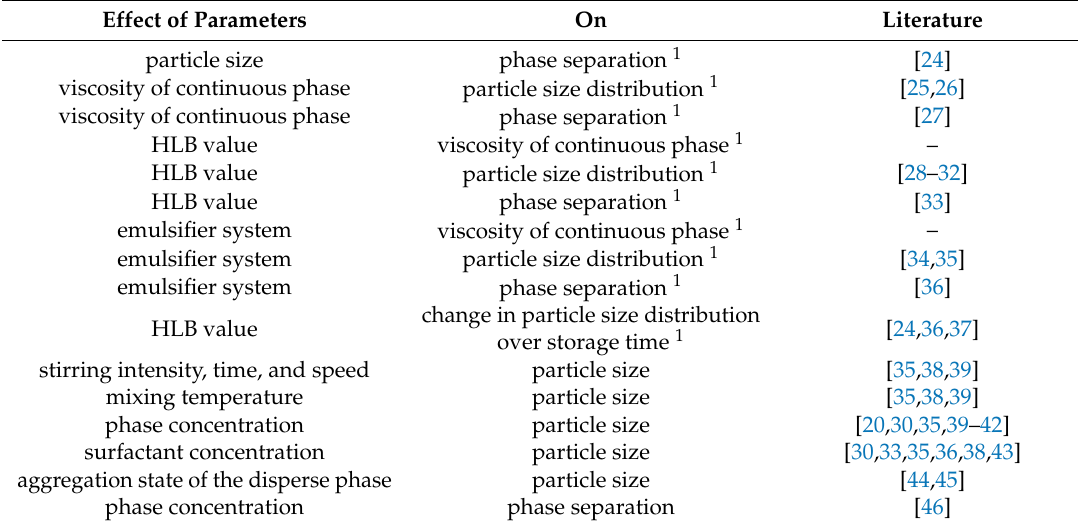
Table 1. Literature overview of the direct and indirect parameters affecting the stability of dispersions. (HLB = Hydrophilic–Lipophilic